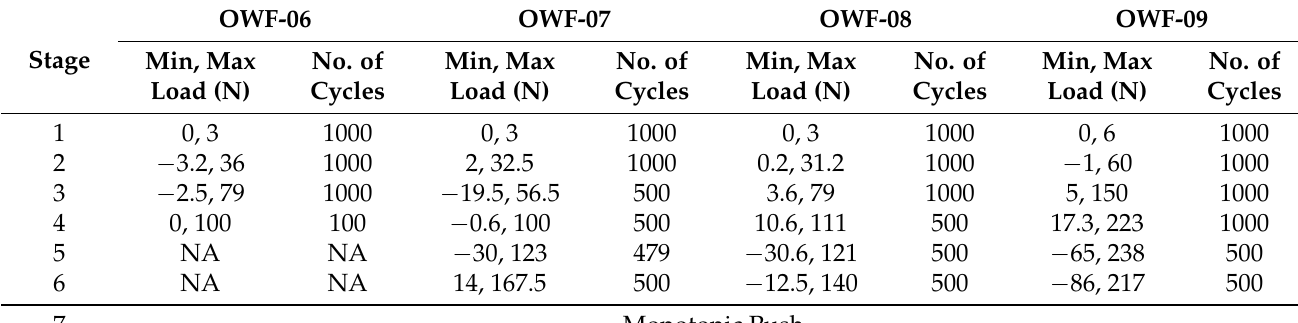
Table 7. Stages and loading profiles for OWF-06 to OWF-09 (after